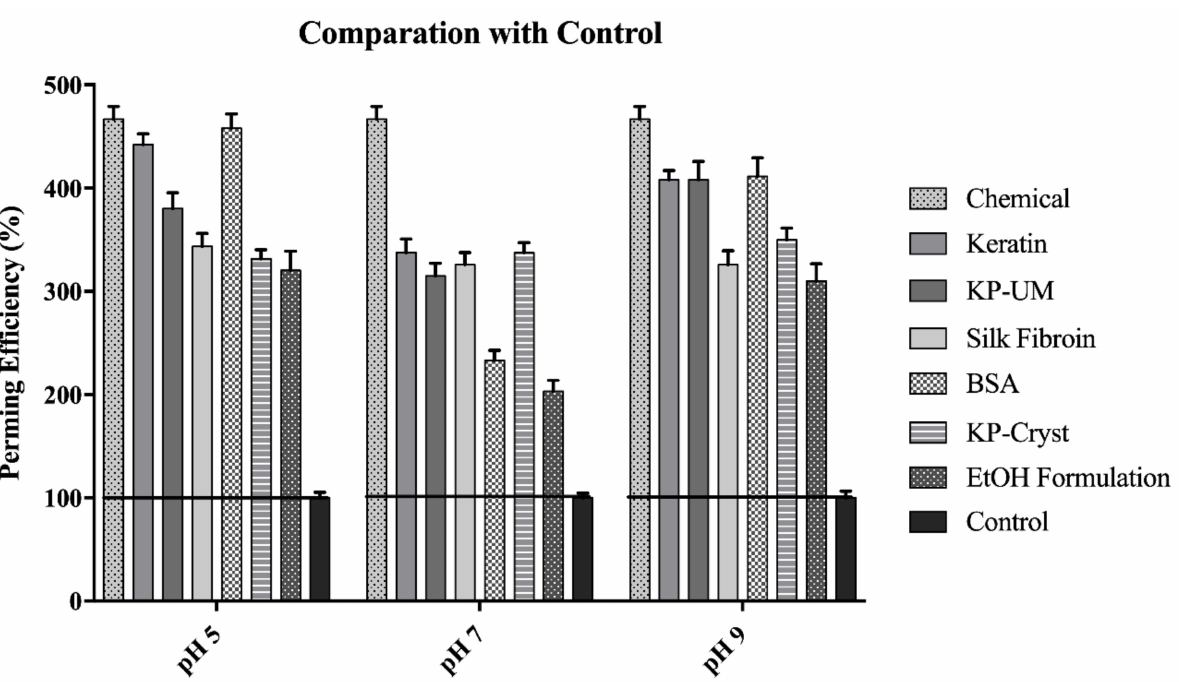
Figure 3. Perming efficiency of the hair tresses treated with the keratin, KP-UM, silk fibroin, BSA and KP-Cryst proteins prepared in phosphate buffer at pH 5, pH 7 or pH 9, compared to the “Control” samples. Hair treated with a commercial formulation for perming (“Chemical”), treated with the ethanolic formulations and phosphate buffers (“EtOH formulation”), or without any treatment (“Control”) were used as controls for the proteins’ capacity to curl Asian hair. The values represent the mean ± SD of two measurements. The data were analyzed by Dunnett’s multiple comparison test, and all of the samples show significative differences ( p -value ≤ 0.0001) when compared with the “Control”